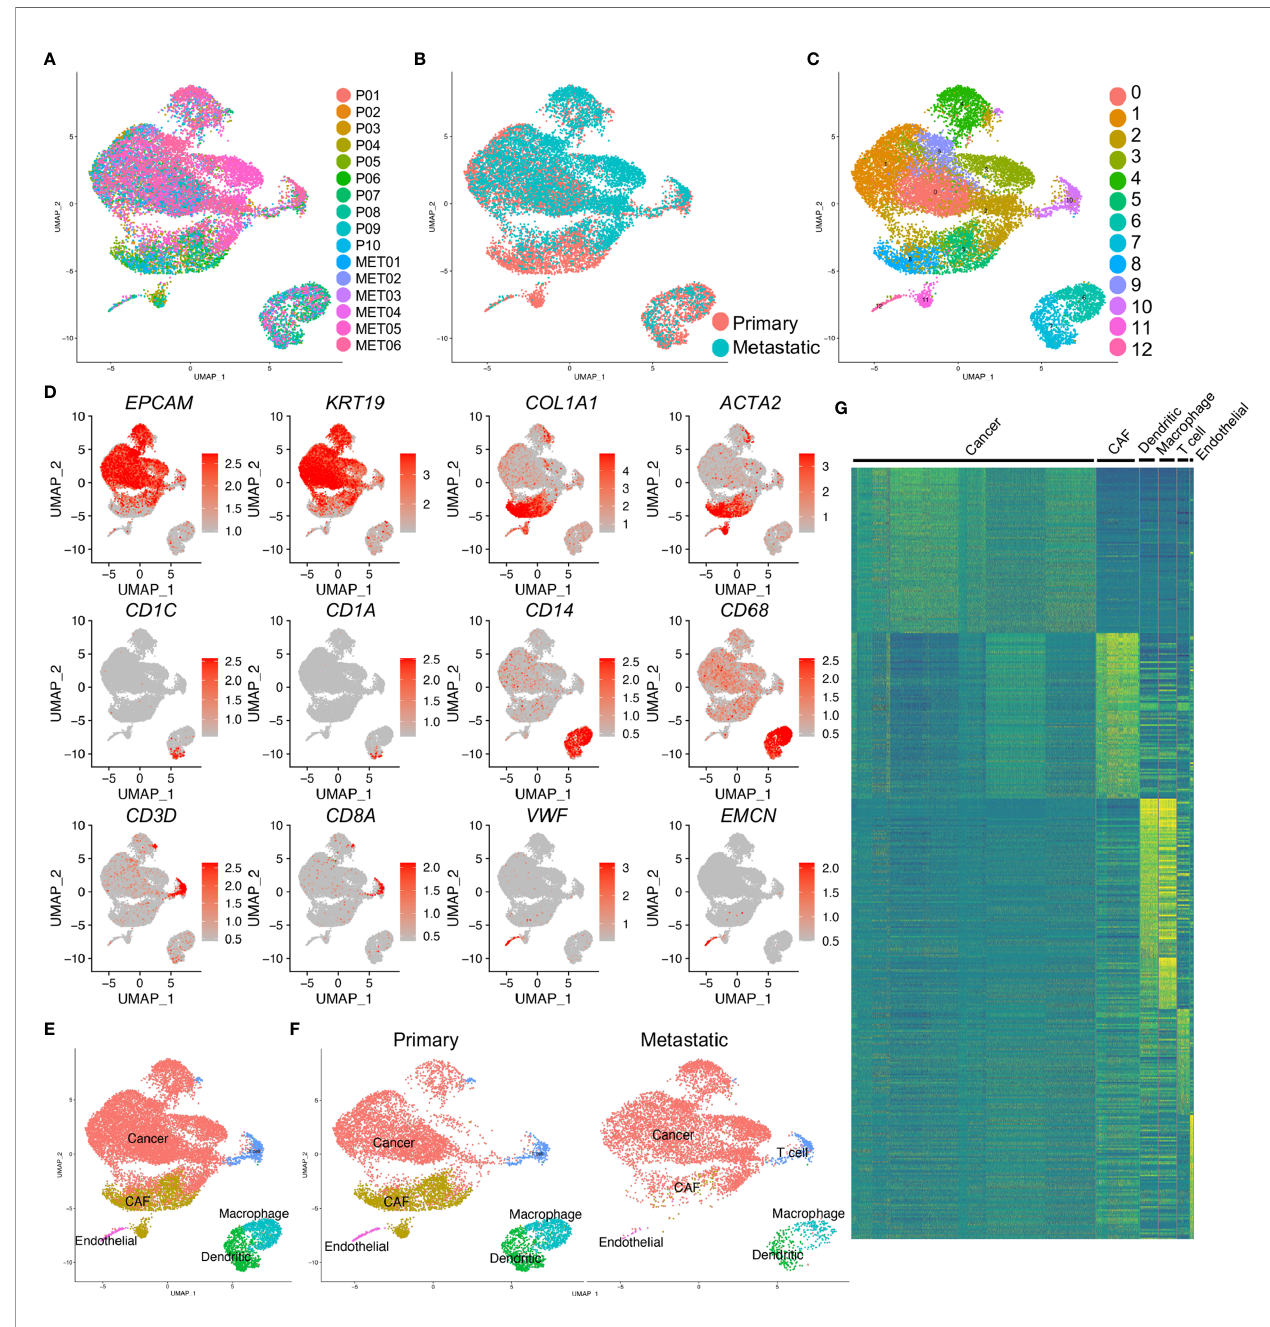
FIGURE 1 | Identi fi cation of cancer cells in both primary and metastatic PDAC. (A) scRNA-seq data of ten primary (P0 – P10) and metastatic (MET0 – MET6) PDAC tumors were integrated. (B) Primary and metastatic PDAC samples were visualized by UMAP grouped by disease status. (C) The cells in the integrated data were divided into thirteen clusters (Clusters 0 – 12). (D) Transcripts of major cell type marker genes were visualized by UMAPs. (E) Six distinct cell types were de fi ned based on the expression of cell type marker in (D) . (F) Cell type of primary and metastatic PDAC by divided UMAPs. (G) Heatmap of top 100 genes of each cell type con fi rmed the distinct signatures of each de fi ned cell type. CAF, cancer associated fi broblasts; cancer, cancer cell, dendritic, dendritic